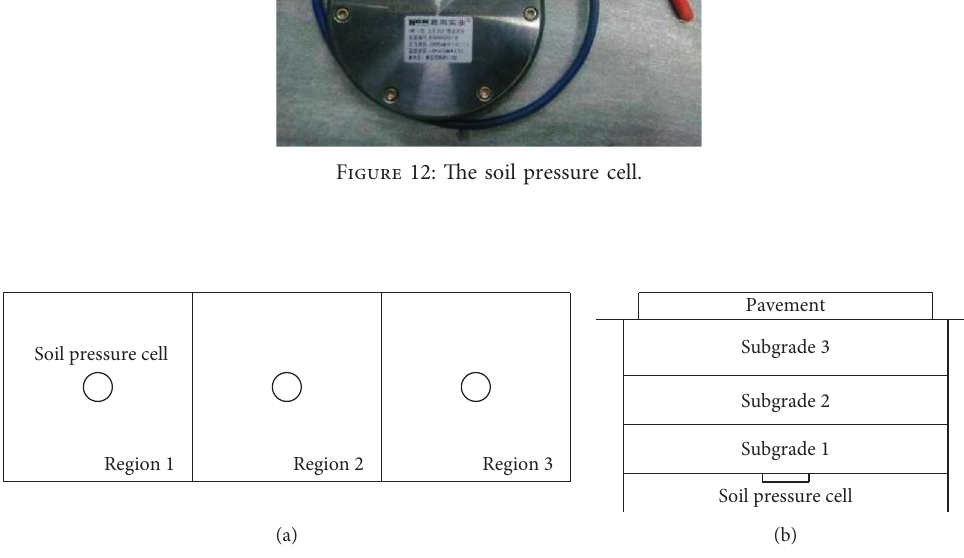
Figure 13: The arrangement of soil pressure cell. (a) The planform of soil pressure cell arrangement. (b) The profile of soil pressure cell